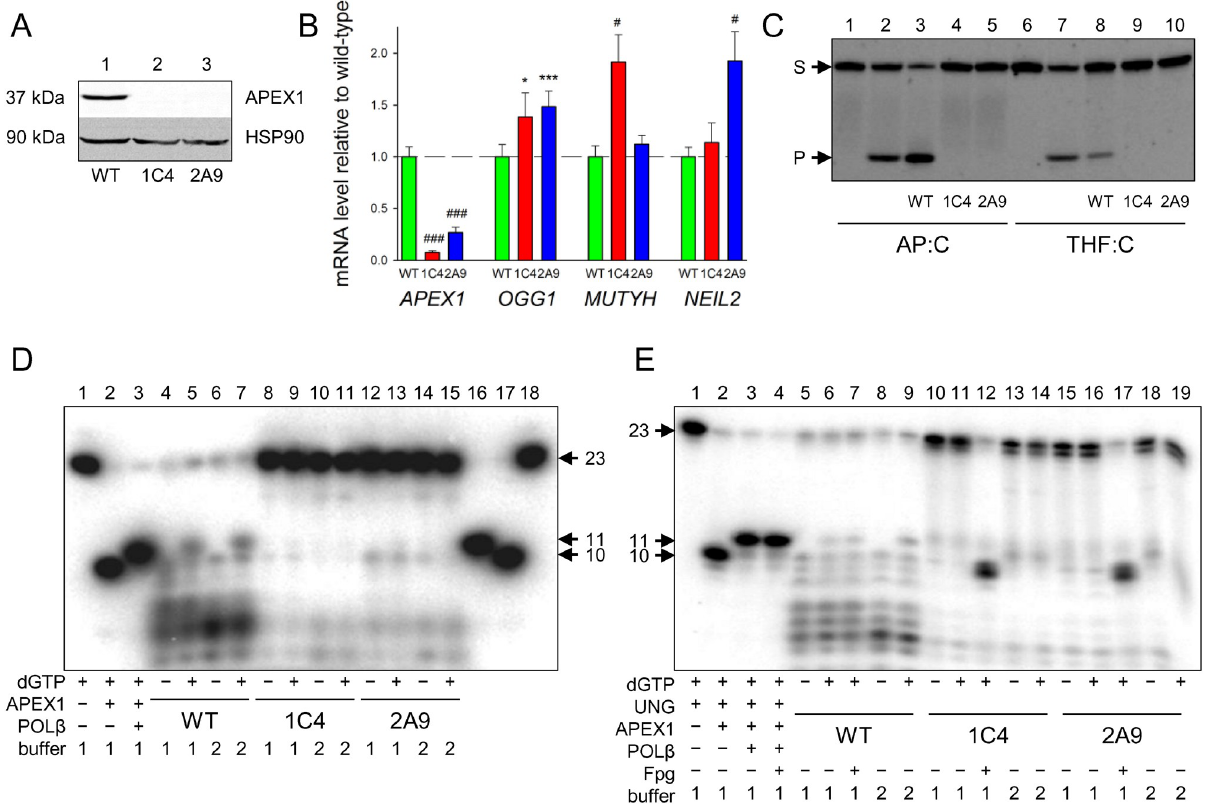
Fig 2. APEX1 knockout cells lack detectable APEX1 protein, AP endonuclease activity, and BER. A, Western blot for APEX1 in the extracts of wild- type HEK 293 ( lane 1 ) and knockout cells 1C4 ( lane 2 ) and 2A9 ( lane 3 ). B, mRNA levels of APEX1 , OGG1 , MUTYH , and NEIL2 genes in 1C4 and 2A9 cells relative to wild-type HEK 293FT. Mean ± s.d. are shown ( n = 4, see Materials and methods for a detailed description). Student’s unpaired t test: � , p < 0.05; ��� , p < 0.005; #, p < 0.001; ###, p < 0.0001. C, cleavage of a 23-mer duplex oligonucleotides containing an AP:C pair ( lanes 1–5 ) or a THF:C pair ( lanes 6–10 ) by extracts of wild-type HEK 293 ( lanes 3 and 8 ) and knockout cells 1C4 ( lanes 4 and 9 ) and 2A9 ( lanes 5 and 10 ). Lanes 1 and 6 , no enzyme or cell extract; lanes 2 and 7 , recombinant APEX1. Arrows mark the mobility of the substrate (S) and the cleavage product (P). D, repair of a THF:C duplex. Lanes 1–3 , repair system reconstituted from purified APEX1 and POL β , as indicated below the gel. Lanes 4–7 , extracts of wild-type HEK 293; lanes 8–11 , extracts of 1C4 cells; lanes 12–15 , extracts of 2A9 cells. Buffer 1, BER buffer, buffer 2, POL β buffer (see Materials and methods). Lanes 16–18 , size markers, as specified by the arrows. E, repair of a U:C duplex. Lanes 1–4 , repair system reconstituted from purified UNG, APEX1 and POL β , as indicated below the gel. Lanes 5–9 , extracts of wild-type HEK 293; lanes 10–14 , extracts of 1C4 cells; lanes 15–19 , extracts of 2A9 cells. Buffers are as in Panel D . Some reactions were post-treated by Fpg to confirm the AP site formation. C–E, representative gels from 3–4